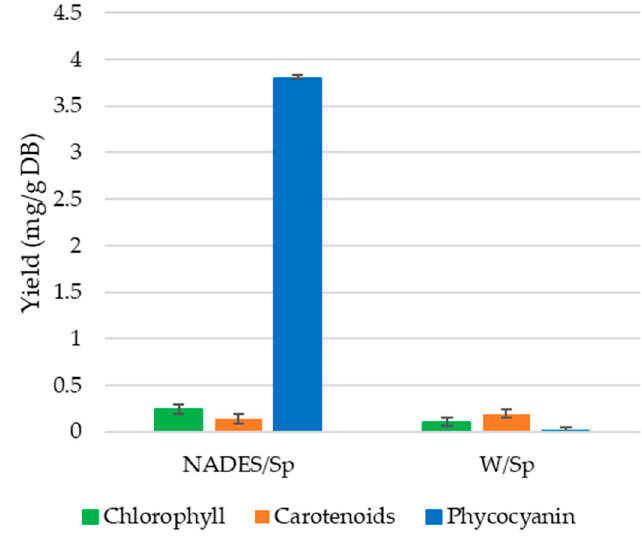
Figure 2. Yield (mg/g Dry Biomass) of W/Sp and NADES/Sp extracts.